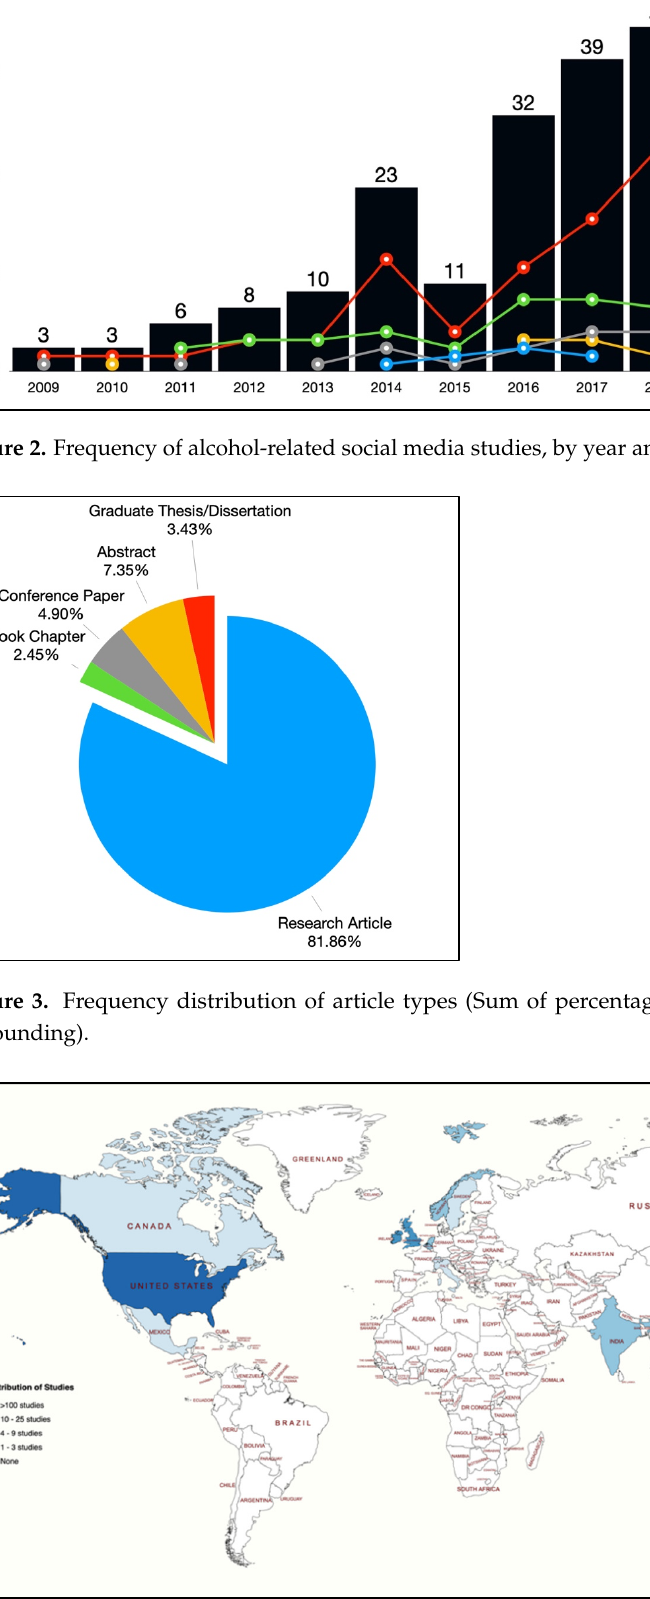
Figure 4. Distribution of studies included in the systematic review by